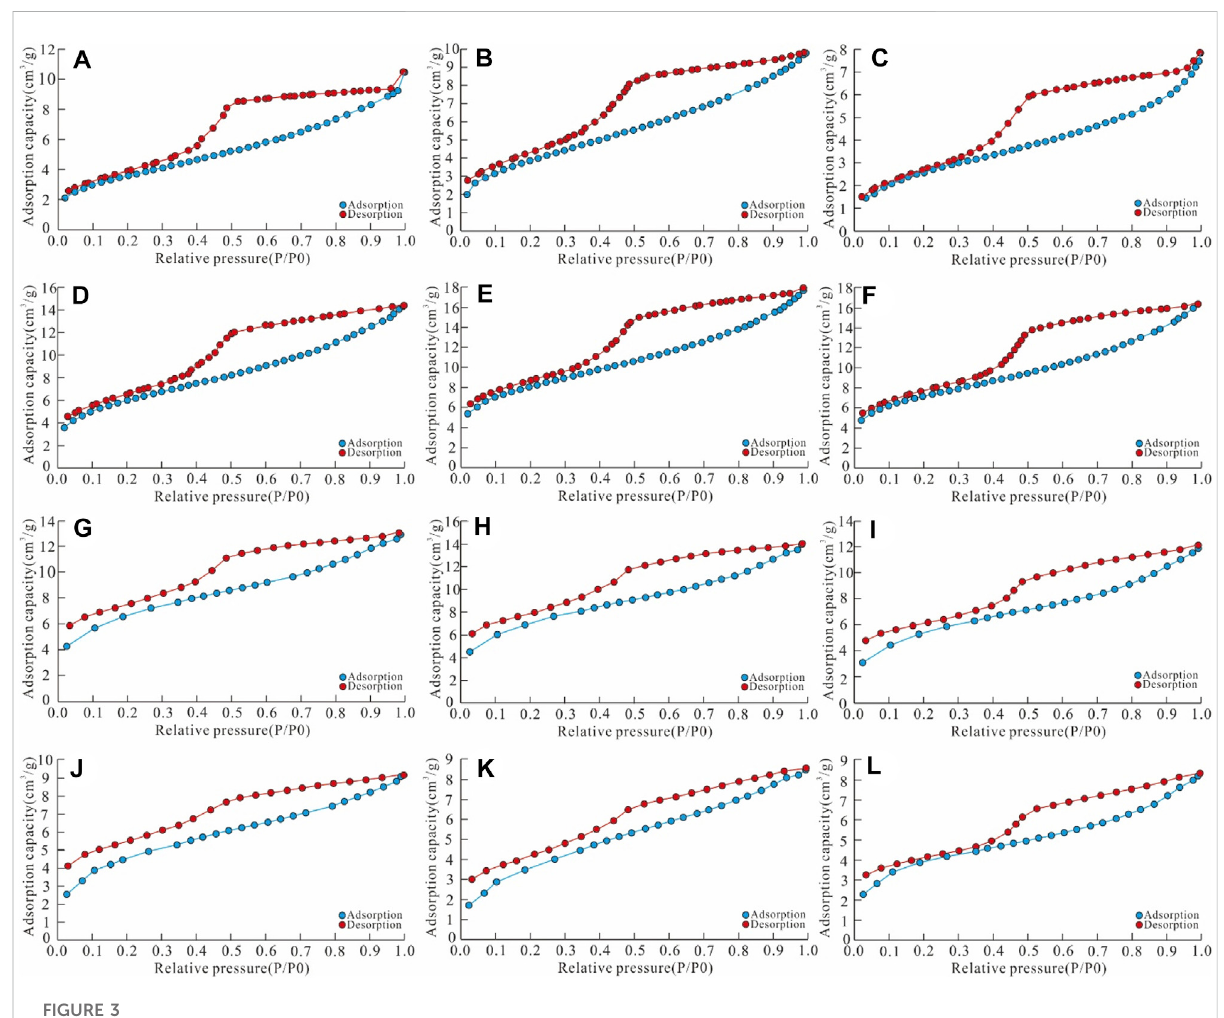
FIGURE 3 Low-temperaturenitrogenadsorption-desorptioncurvesoftheLongmaxi Formation shale intheChangning area. (A – F) isfromZK 1 ,and (G – L) is from ZK 2